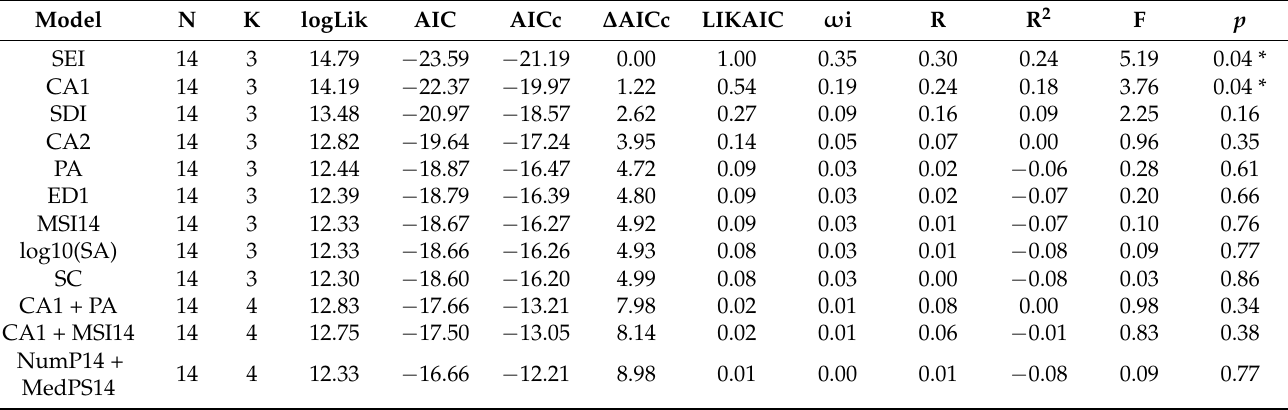
Table 3. Models proposed to examine the relationship between the expected heterozygosity (He) of C. yucatanicus in the northern Yucatan Peninsula Mexico and landscape structure and composition. The table shows the Shannon Equity Index (SEI), suitable habitat proportion (CA1), fragments diversity index (SDI), disturbed habitat proportion (CA2), risk index for the proximity of human settlements (PA), fragments edge density of suitable habitat (ED1), fragments average shape index of suitable habitat (MSI14), distance to human settlements (SA), distance to road (SC), fragments number of suitable habitat (NumP14), and average size of fragments of suitable habitat (MedPS14). Plausible models (*) are ordered according to ∆ AICc values: N: observations number, k: parameters